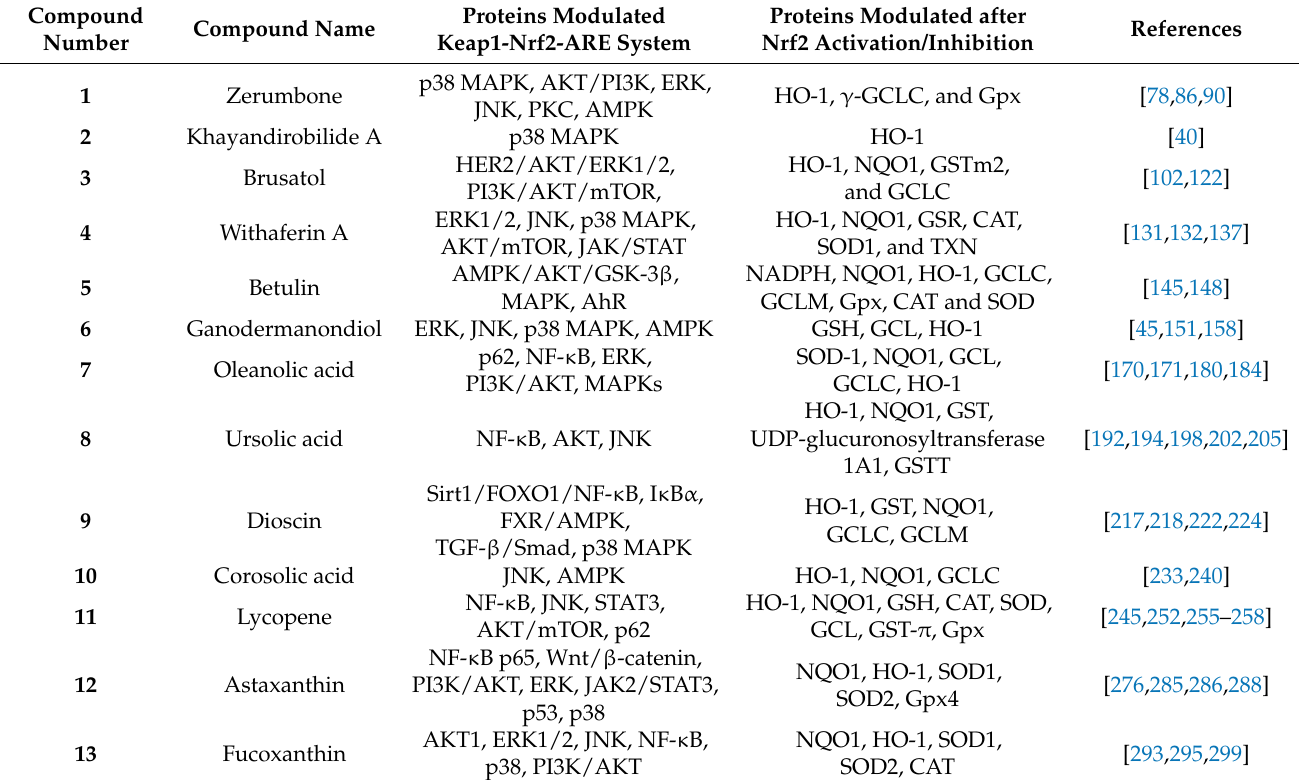
Table 3. Cellular signaling and targeted downstream proteins of dietary